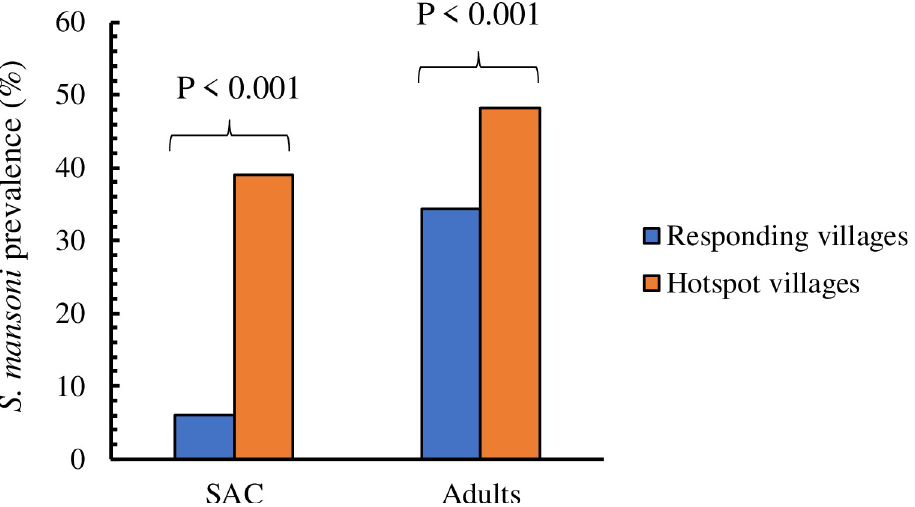
Fig 1. Prevalence of Schistosoma mansoni for PHS and R villages by Kato-Katz in 2018.